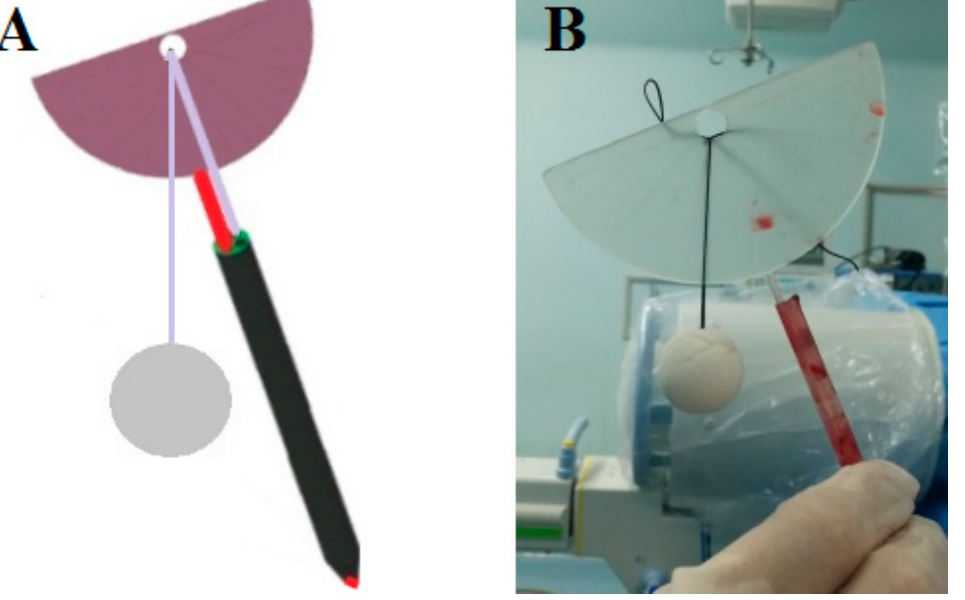
Figure 1. Schematic diagram and intraoperative image showing the guide device. ( A ) Schematic diagram of the guide device. ( B ) Intraoperative image showing the 3D-printed guide device.